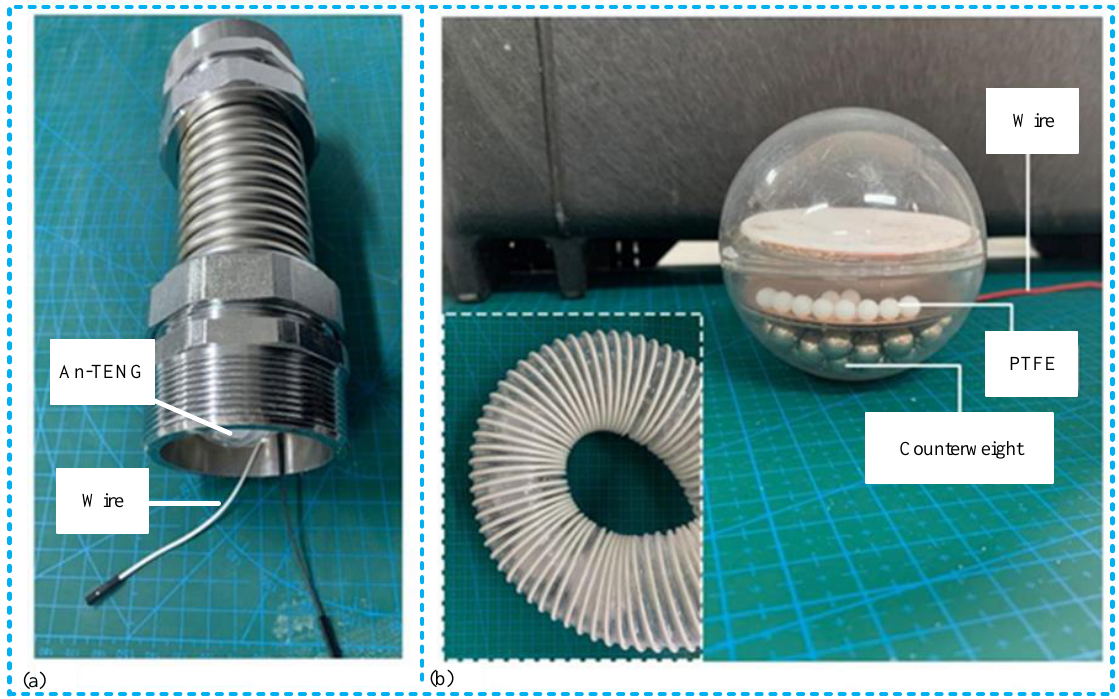
Figure 2. A physical image of the RSV − TENG. ( a ) A physical installation image of the RSV − TENG; and ( b ) the structural diagram of the internal sensor of RSV − TENG.